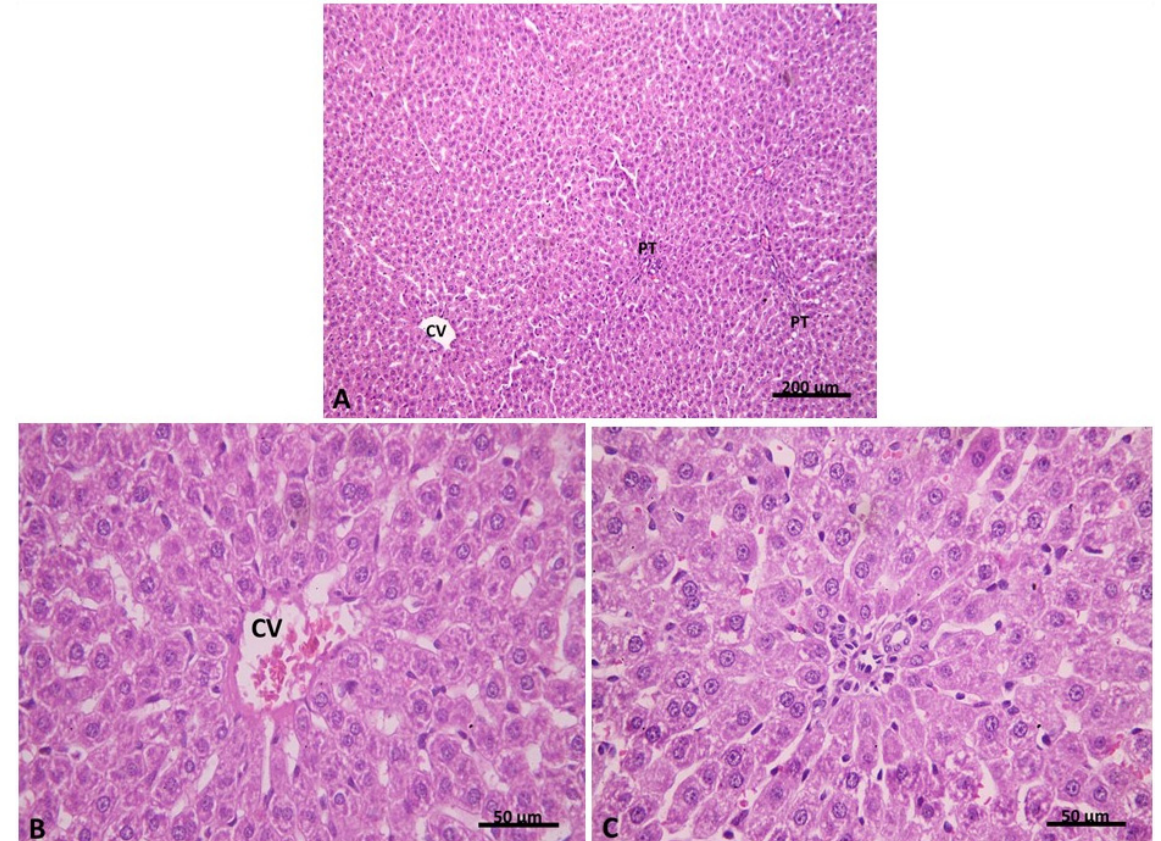
Figure 7. ( A ) showing hepatic architecture more or less similar to the control group with the central vein (CV) and peripheral portal tracts (PT). ( B ) Group III. H&E ×100 showing congested central vein (CV). Hepatocytes are seen with acidophilic cytoplasm and central vesicular nuclei. ( C ) Group IIIa. H&E ×400 showing apparently normal portal area with an apparent decrease in cellular infiltration. Group III. H&E ×400.